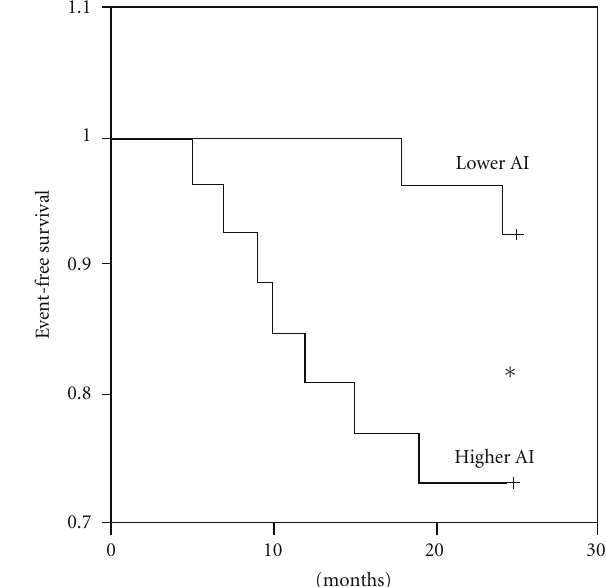
Figure 3: Kaplan-Meier analysis on whole hemodialysis patients showed that those without diabetes experienced cardiovascular events less frequently than those with diabetes. Log-rank test depicted that there was a significant di ff erence in cardiovascular events between patients with diabetes and those without.